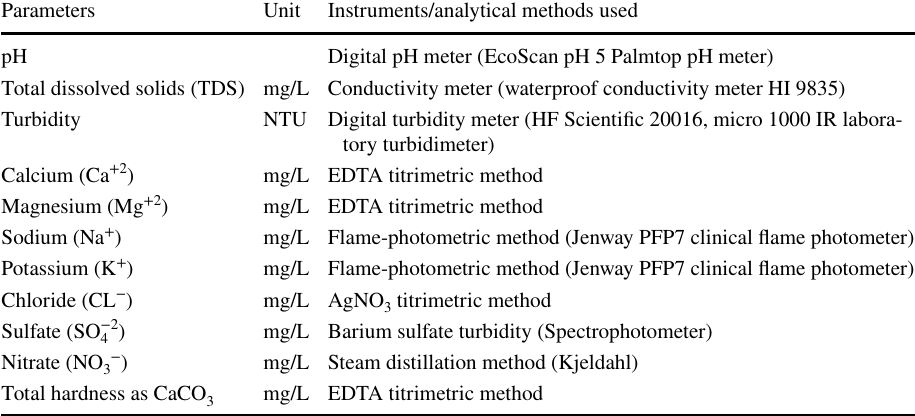
Table 2 Water quality parameters, analytical methods, and instruments used for the current